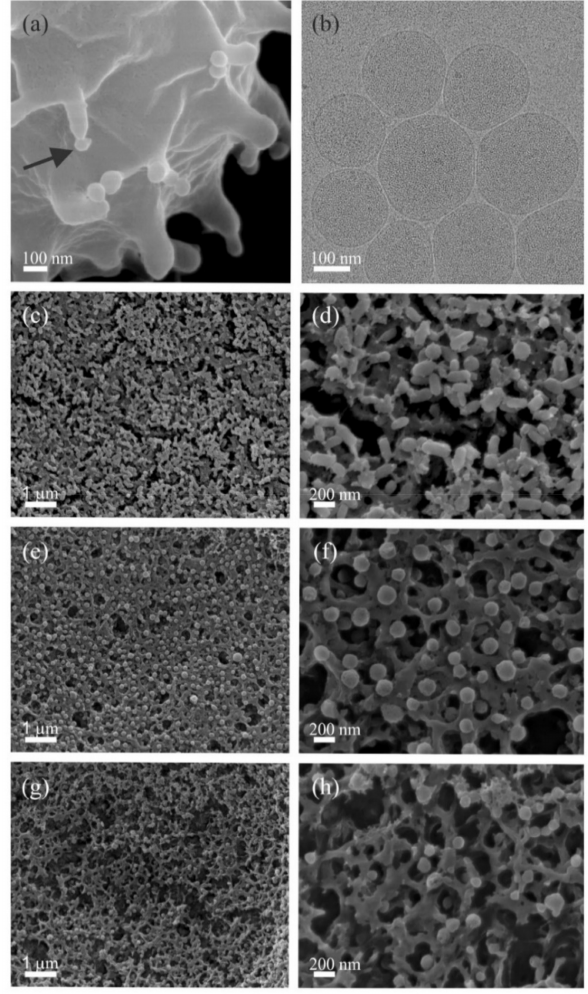
Figure 1. SEM ( a , c – h ) and cryo-TEM (b) images of hbEVs. ( a ) Budding echinocyte (arrow points to the bud); ( b – d ) isolated hbEVs in isotonic medium (PBS–citrate, 300 mOsm/L); ( e , f ) isolated hbEVs suspended in hypotonic medium (PBS–citrate, 50 mOsm/L); ( g , h ) osolated hbEVs in medium (PBS–citrate, 300 mOsm/L) with added surfactant Triton X-100 (150 µ mol/L). Isolates were fixed for imaging by SEM on the filter paper. The scale bars in ( c ) and ( d ) also apply to the panels ( e , g )